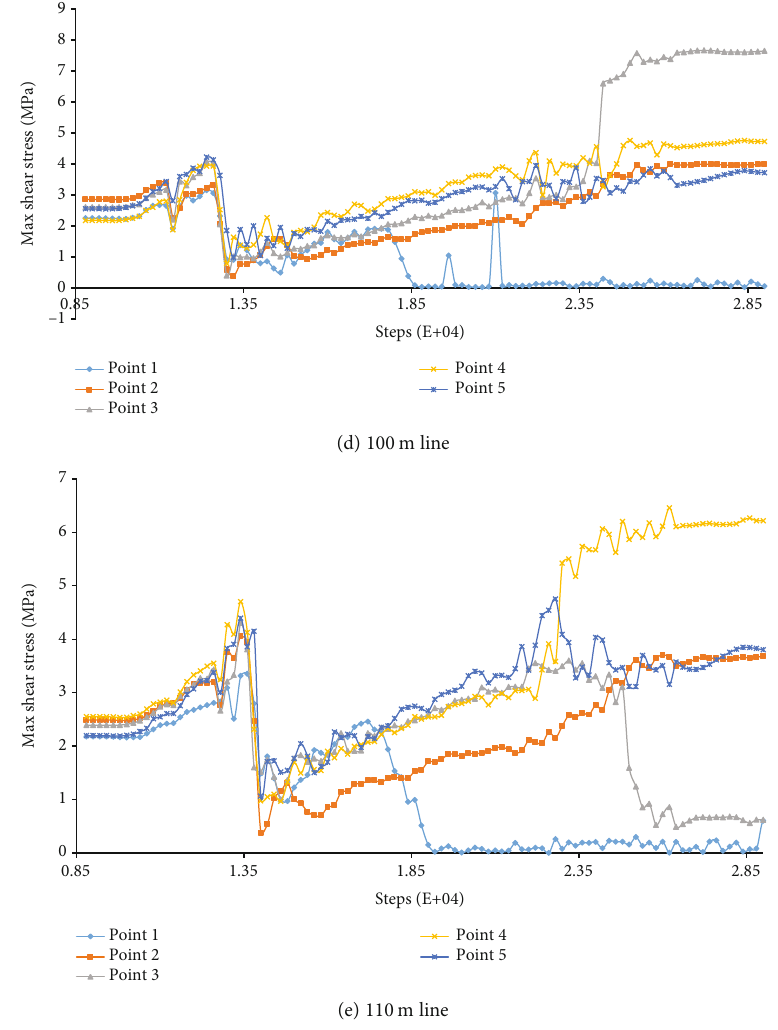
Figure 11: L = 200 m, H = 2 : 5 M shear stress